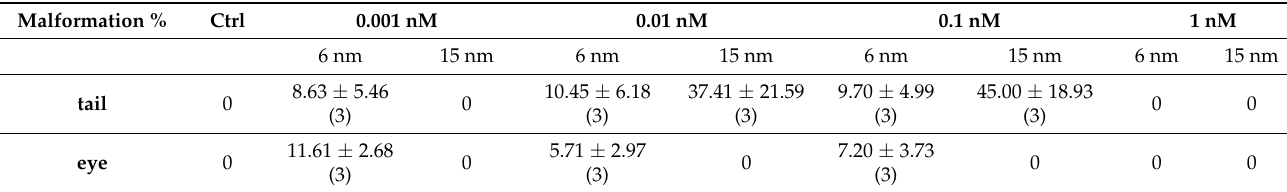
Figure 5. Tail and eye malformations of zebrafish embryos exposed or not (CTRL) to 0.001–1 nM GNP@PMA ( A ) or GNP@PEG ( B ), 6 nm or 15 nm; n.d., not detected. Table 4. Percentage malformation of embryos exposed to 0.001–1 nM of 6 or 15 nm GNP@PEG. Mean ± SE of three